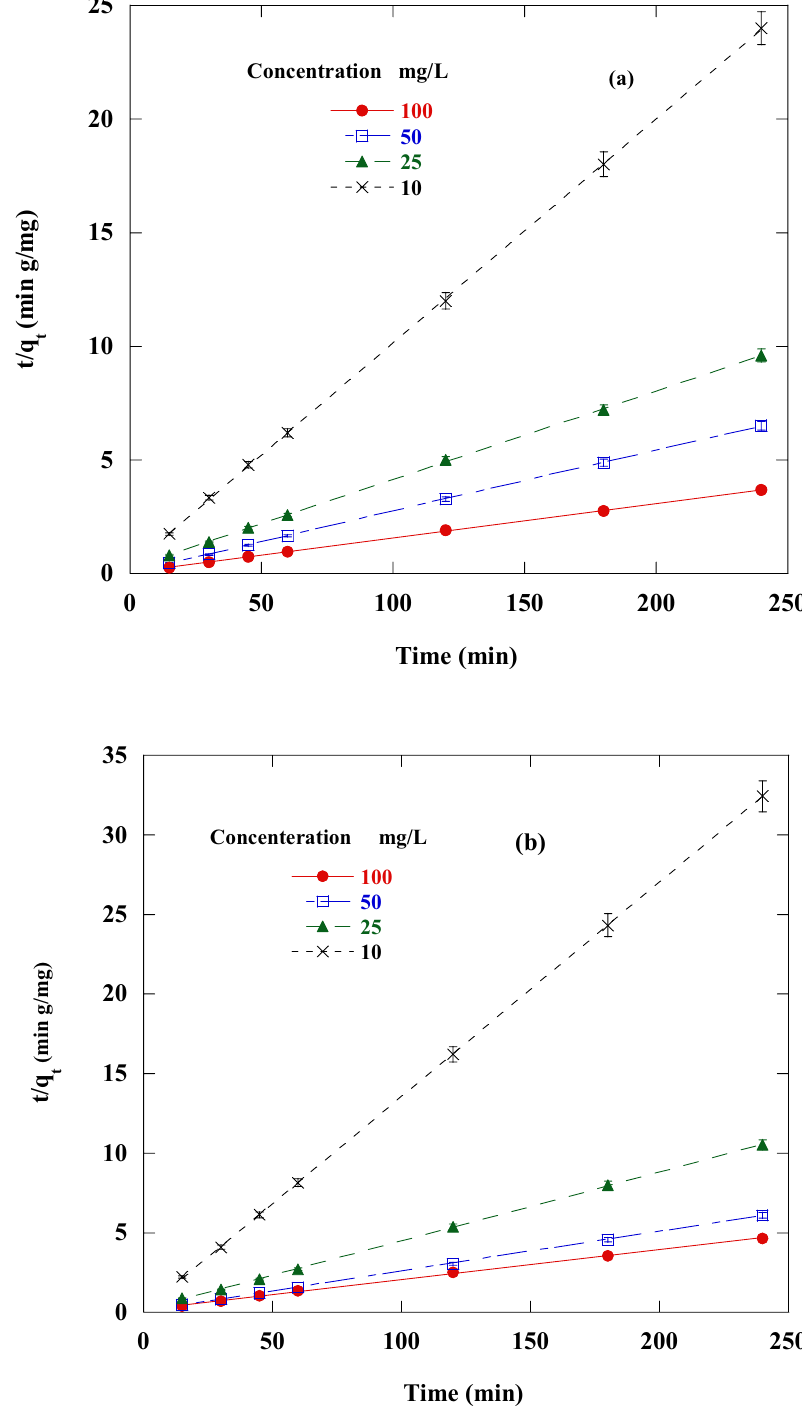
Figure 11. Pseudo-second-order sorption kinetics of Disperse red 60 dye at 20 °C and pH 6 by 50 mg of: ( a ) CF, ( b )